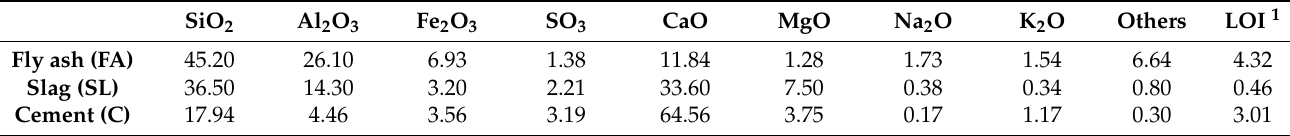
Table 2. Chemical composition (X-ray diffraction) of fly ash, slag, and cement.